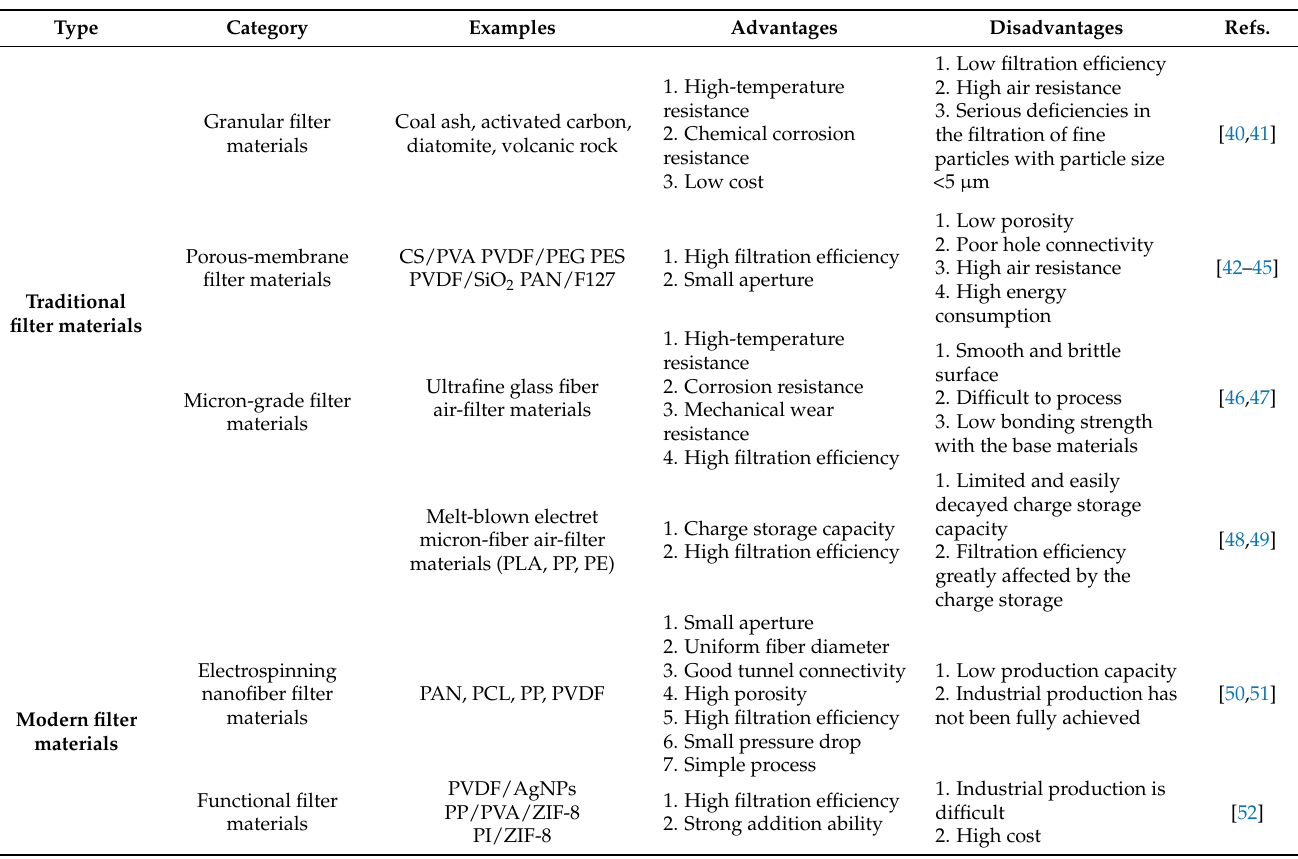
Table 1. Classification of air-filter